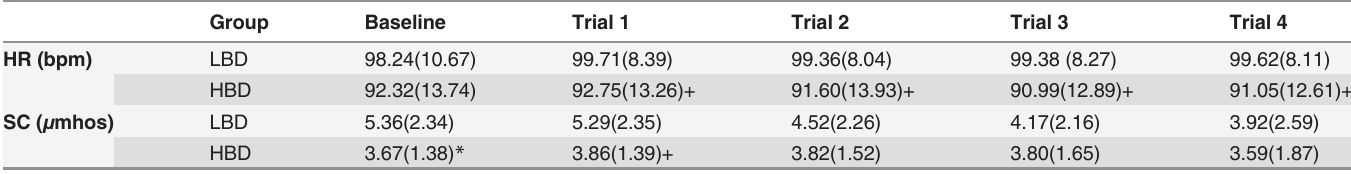
Table 2. Mean (and standard deviation) of averaged heart rate (HR) and skin conductance (SC) during the five experimental periods in the low body dissatisfaction (LBD) and high body dissatisfaction (HBD) groups.